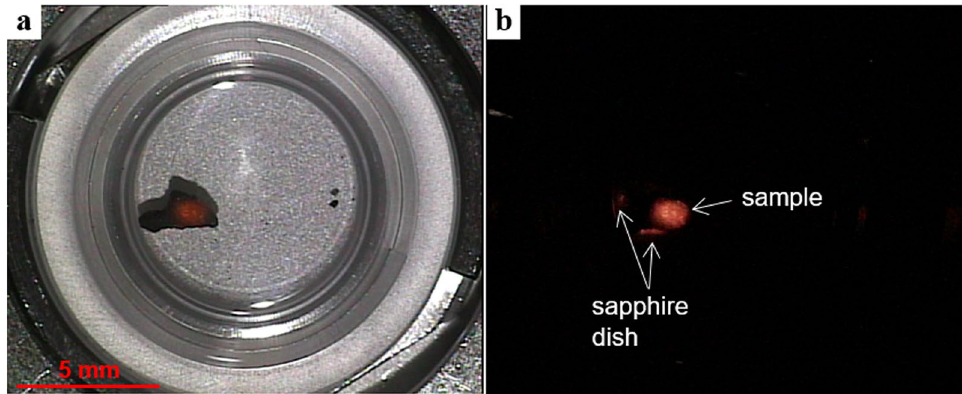
Fig. 3 Incident beam spot illuminating on the individual sample (C0033) and sapphire dish. Optical images with a internal light and b incident beam